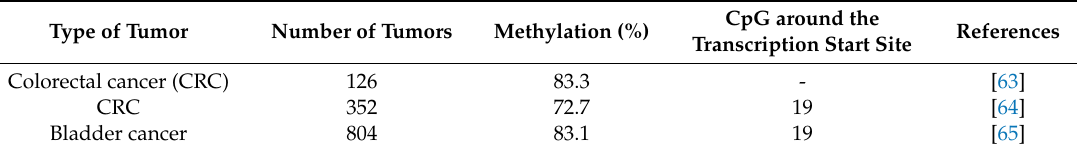
Table 1. Changes in KISS1 promoter methylation in